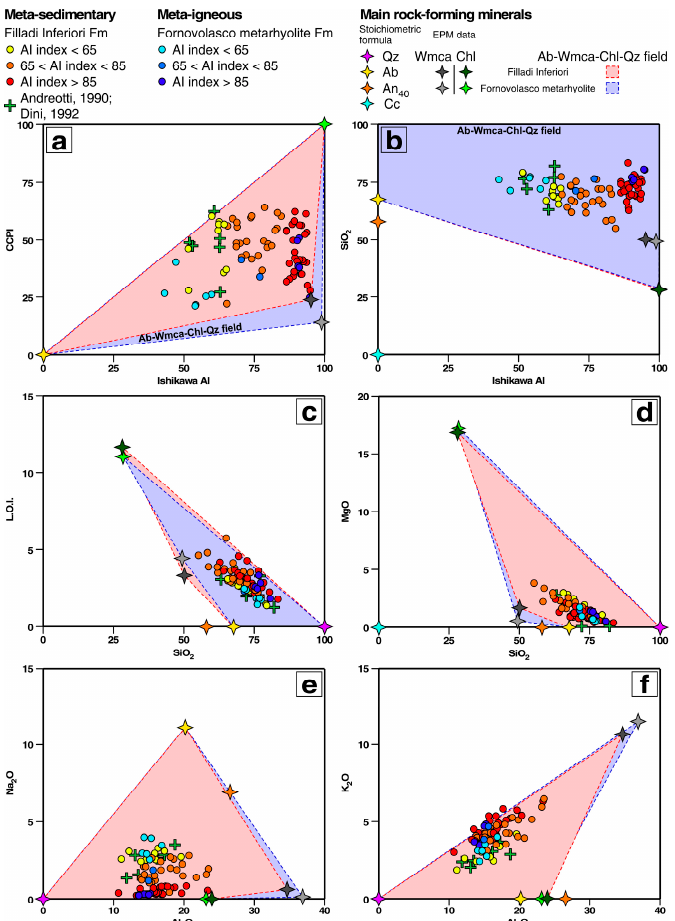
Figure 6. ( a – f ) Major elements variability plots of the “Filladi Inferiori” and Fornovolasco Metarhyolites Fms. ( a ) Alteration box plot (see text for further details), ( b ) SiO 2 vs AI, ( c ) L.O.I. (Loss On Ignition) vs SiO 2 , ( d ) MgO vs SiO 2 , ( e ) Na 2 O vs Al 2 O 3 , and ( f ) K 2 O vs Al 2 O 3 . The composition of the main rock-forming minerals is also reported (see text for further details). The red and blue areas represent the composition of rock-forming minerals exclusively by variable proportion of Ab, Wmca, Chl, and quartz, for “Filladi Inferiori” and Fornovolasco Metarhyolites Fms, respectively. Mineral abbreviation: Ab, albite; An 40 , plagioclase “Andesine”; Cc, calcite; Chl, chlorite; Qz, quartz; Wmca, white mica. The major elements are expressed in wt%.